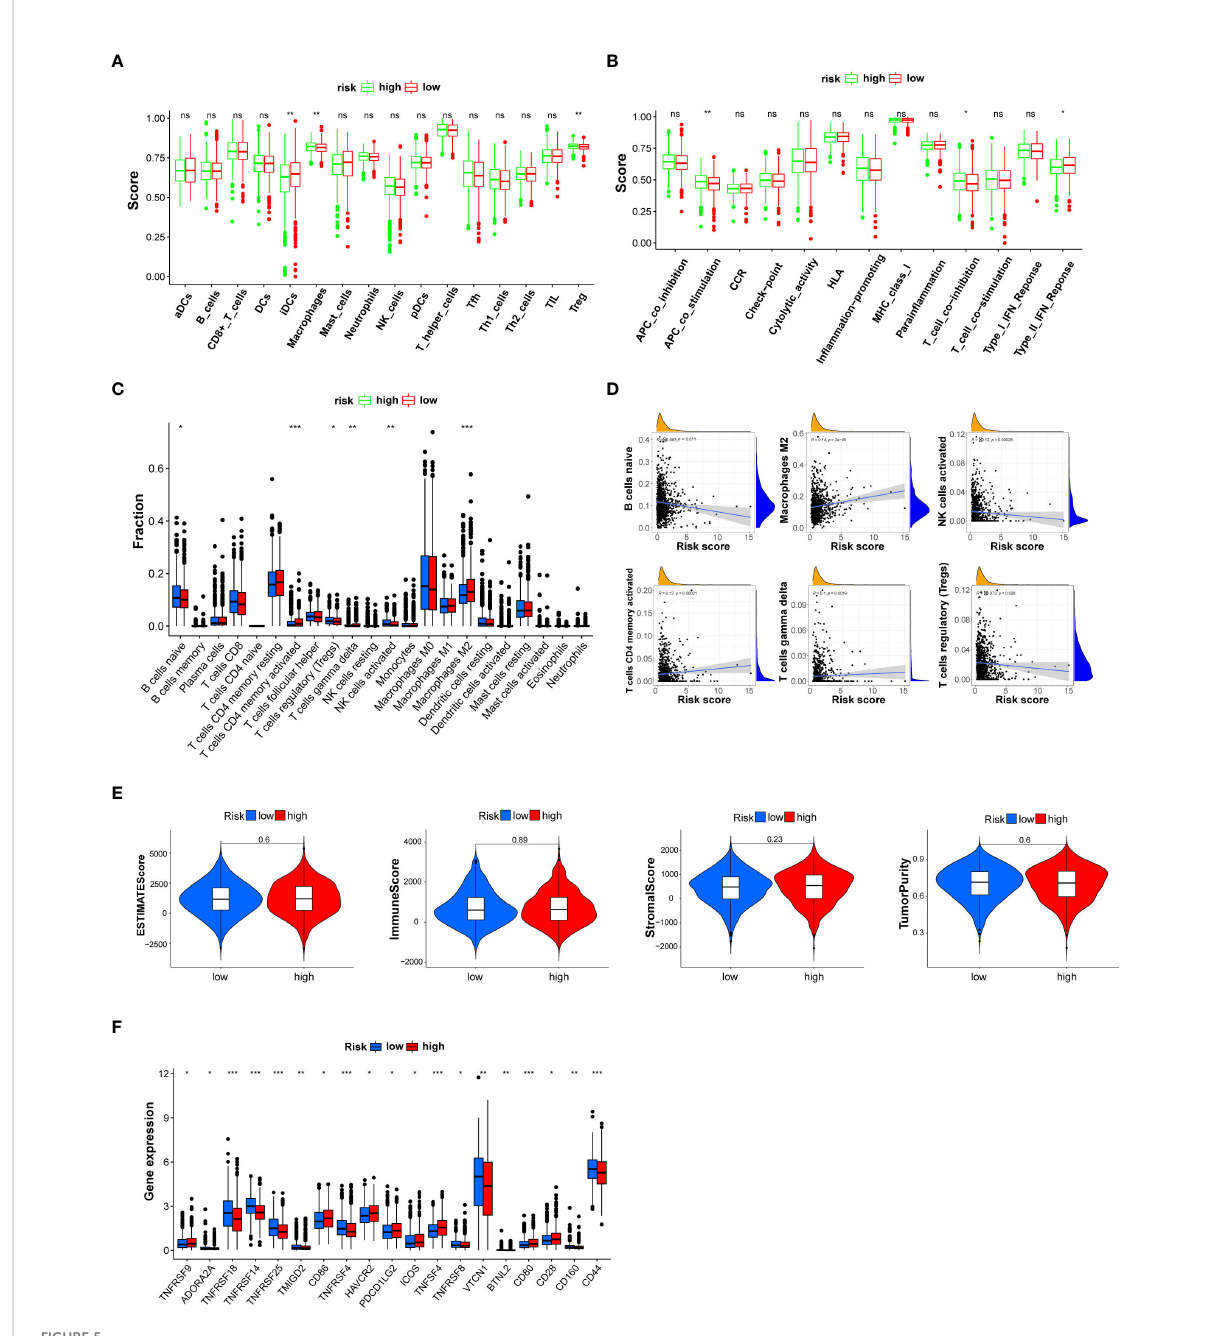
FIGURE 5 Box plot for the single-sample gene set enrichment analysis (ssGSEA) immune score, CIBERSORT immune cell fraction, and ESTIMATE immune fi ltration analysis between patients in the high- and low-risk groups categorized by a median risk score. (A) The scores of 16 immune cells are estimated by ssGSEA. (B) The scores of 13 immune-related functions are calculated by ssGSEA. (C) The fraction of each immune cell is estimated by CIBERSORT. (D) Linear correlation analysis between the fraction of each immune cell and risk score. (E) ESTIMATE score, immune score, stromal score, and tumor purity. (F) The expression level of immune checkpoint genes is statistically different between the high- and low- risk breast cancer groups. NK, natural killer; DCs, dendritic cells; iDCs, immature DCs; pDCs, plasmacytoid dendritic cells; TIL, tumor-in fi ltrating lymphocyte; CCR, cytokine – cytokine receptor; APC, antigen-presenting cell. Adjusted P -values are shown as ns (not signi fi cant), * P < 0.05, ** P < 0.01, *** P <